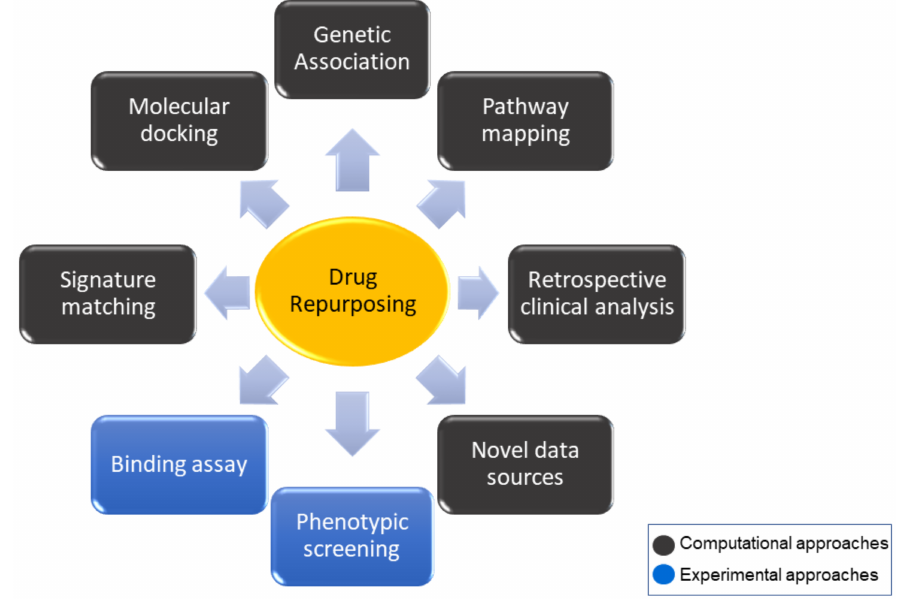
Figure 1. Diagram of the most common approaches to drug repurposing